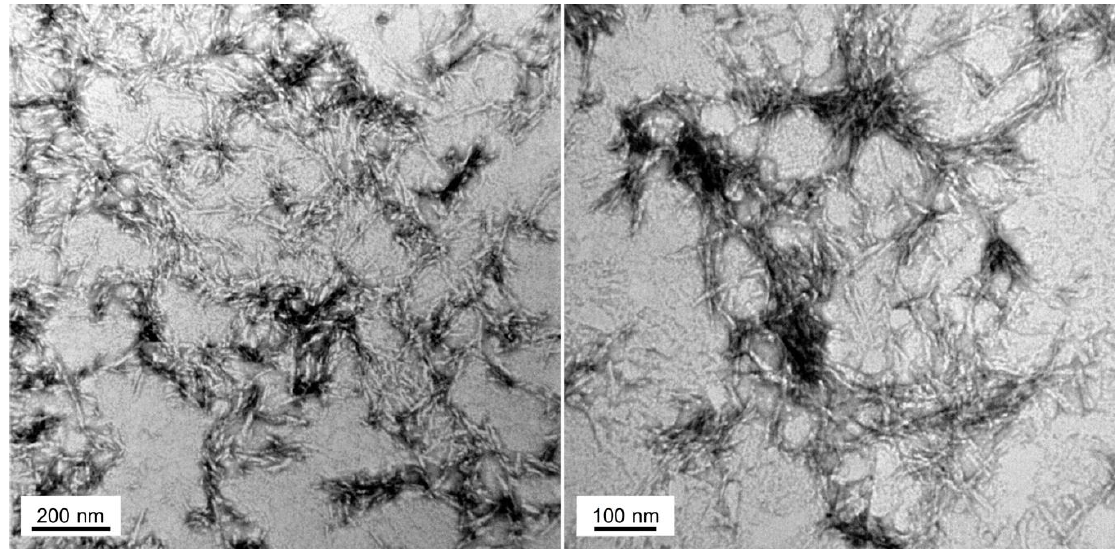
Figure 5. Fibrillar structure of Hsf1 cryptic amyloid core. Representative electron micrographs of Hsf1 aggregated peptide at 100 μM in PBS after 120 h of incubation at 25 °C.